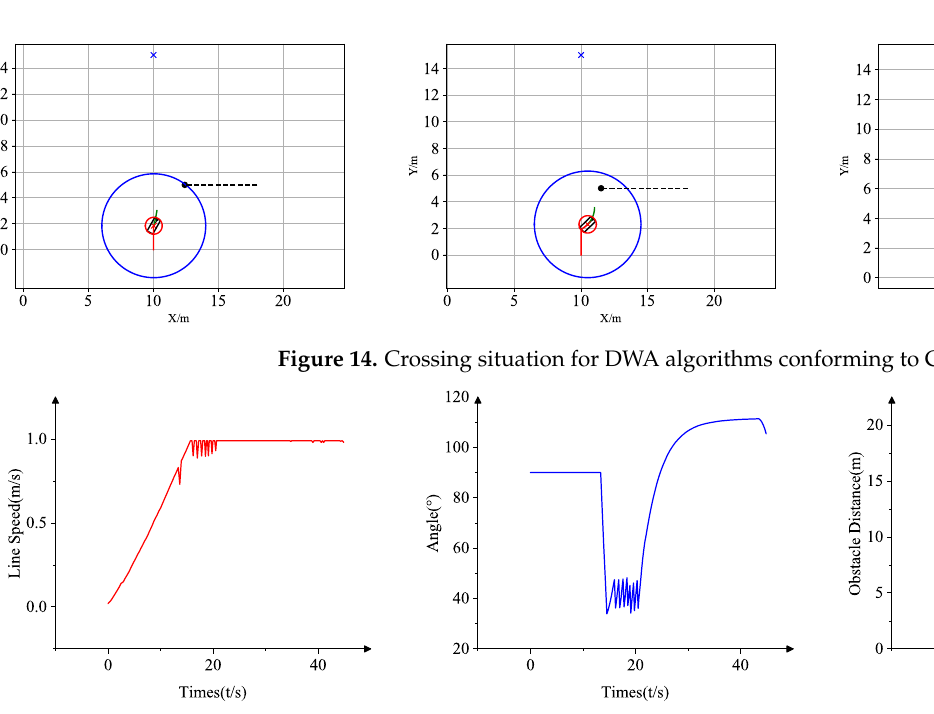
Figure 13. Parameters of the CCDWA algorithm for overtaking situation. (3) Crossing situation